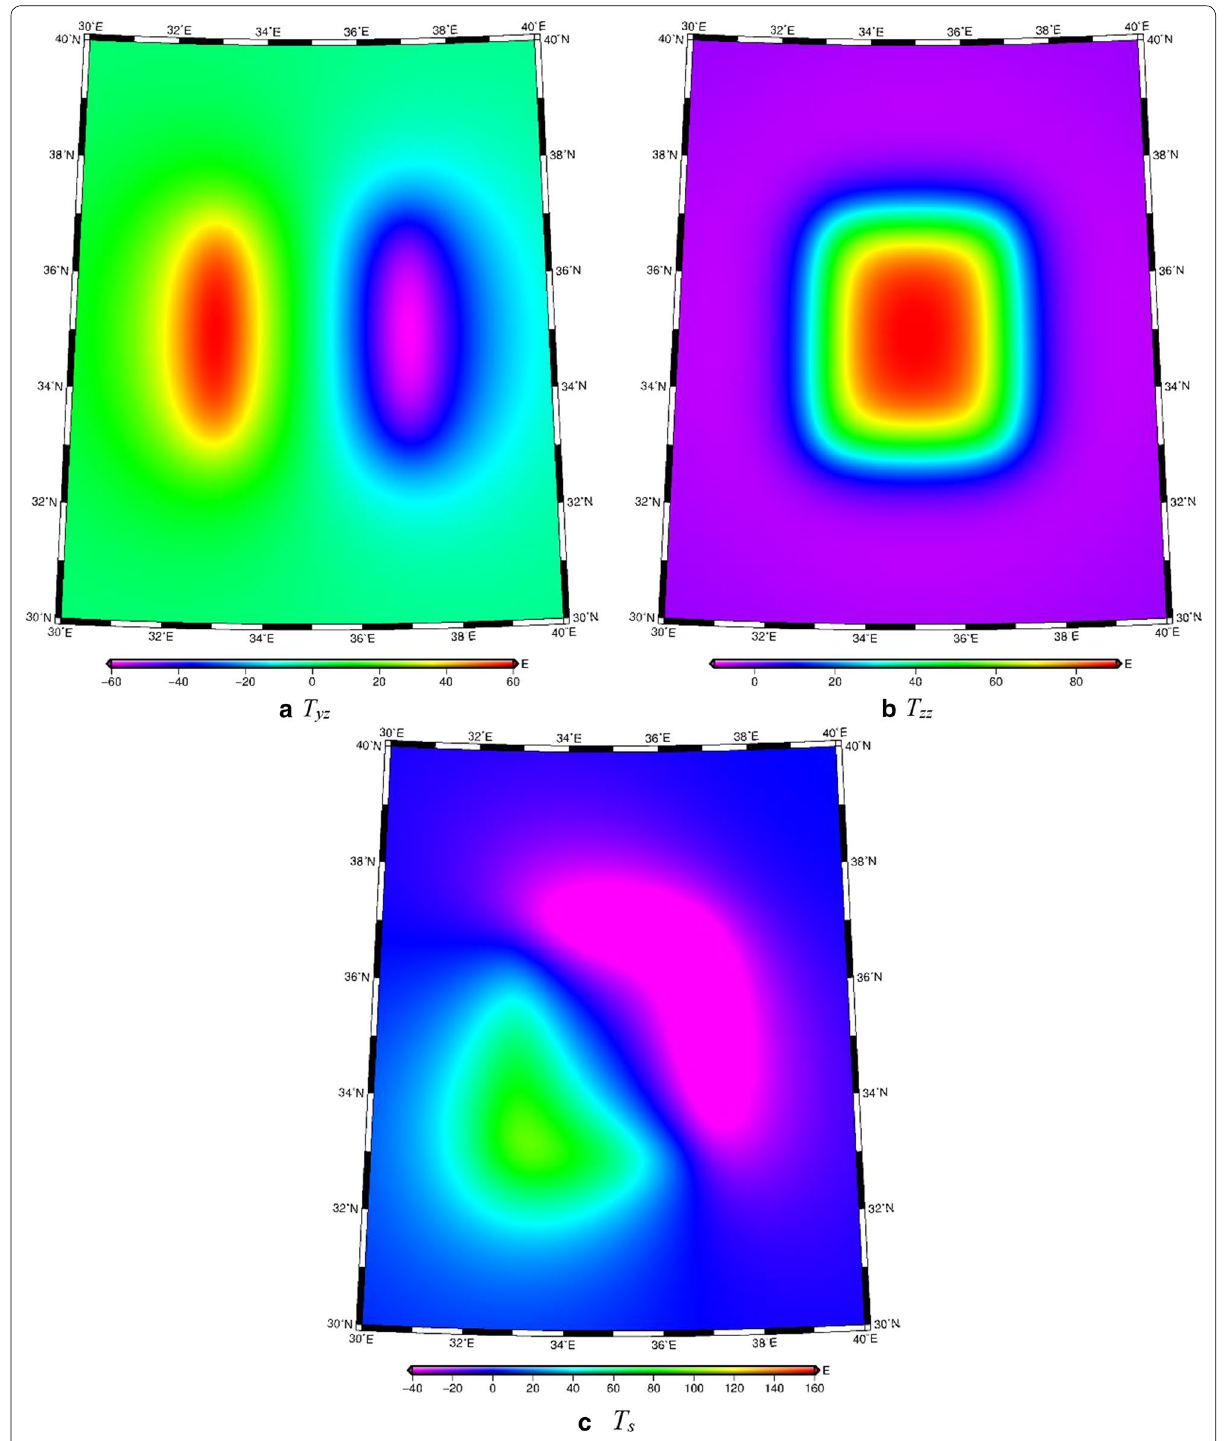
Fig. 4 Artificial theoretical datasets of the GGT for single model, a and b are T yz and T zz components of the GGT, respectively, and c T s is the summa- tion of T xx , T xy , T xz , T yy , T yz and T